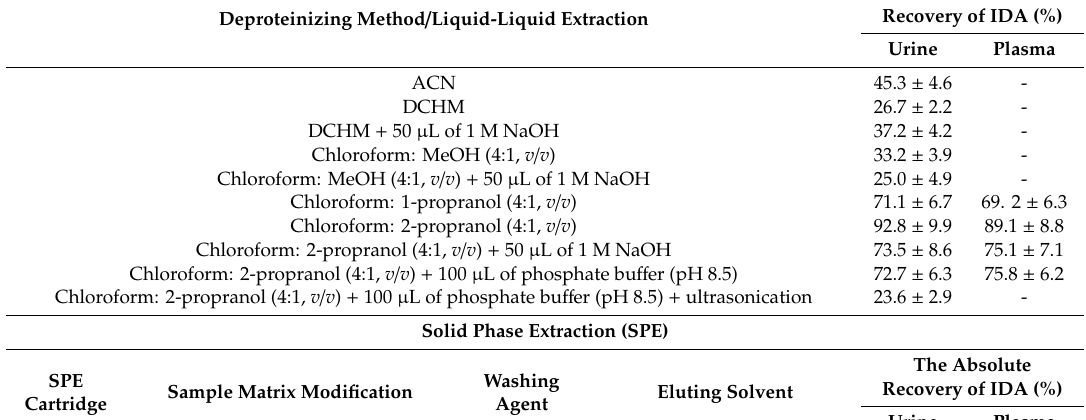
Table1. AbsoluterecoveryresultsforIDAfromurineandplasmaafterusingvarioussamplepreparation procedures ( n = 3) (mean ±